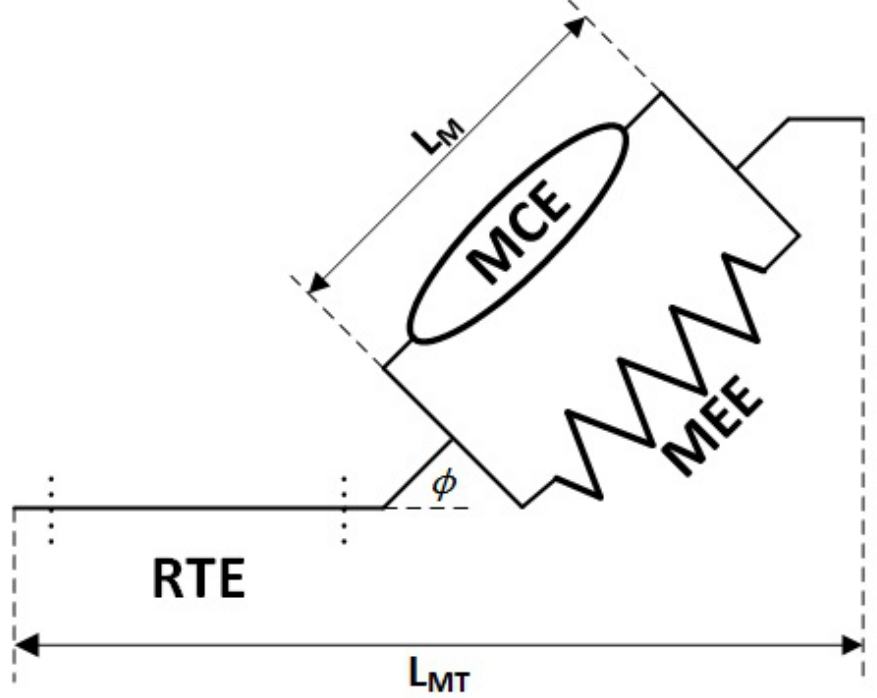
Figure 3. A Hill-type muscle model defines the dynamic contractile properties of the musculotendon unit. This model is made up of the following three components: muscle contractile element (MCE), muscle elastic element (MEE) and rigid tendon element (RTE). The MCE models the active forces of the muscle unit while the MEE models the elastic properties of the muscle unit. The RTE is modelled as a rigid body that transfers muscle force directly to attachment points on the bone. L MT is the length of the musculotendon unit; L M is the length of the muscle unit; and φ is the pennation